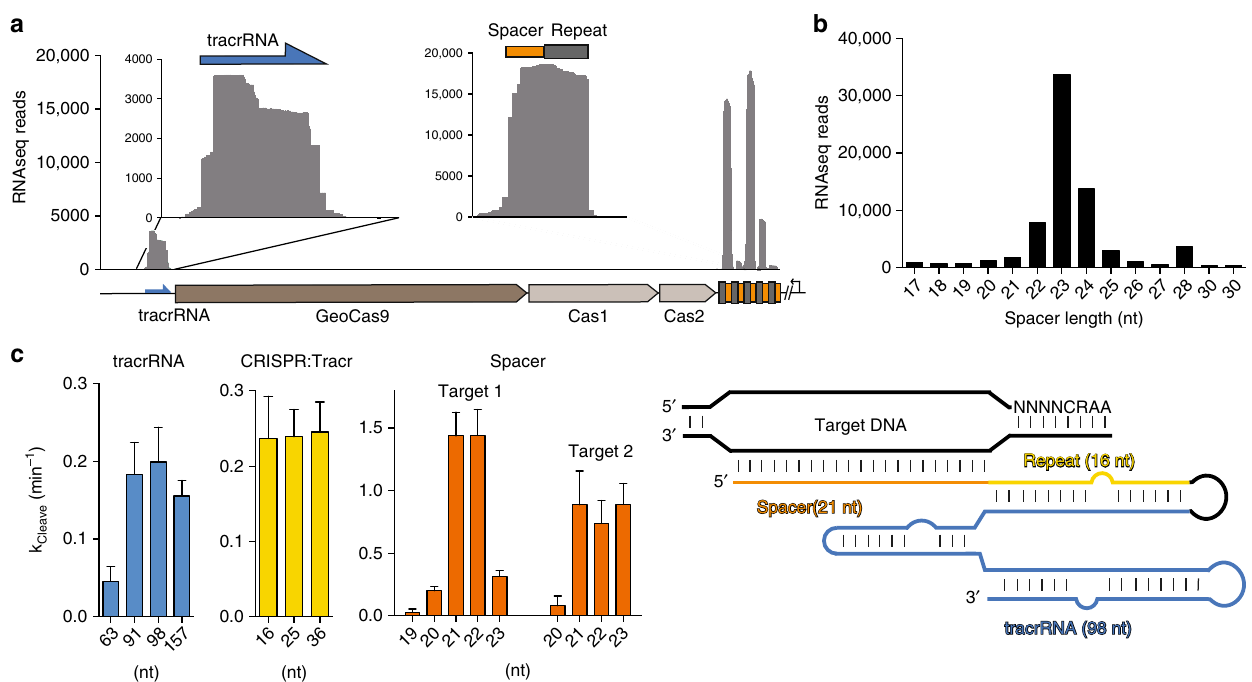
Fig. 3 Small RNA-seq and sgRNA engineering for GeoCas9. a Small RNA sequenced from G. stearothermophilus mapped to the CRISPR locus. Inset shows enlargement of the region corresponding to the tracrRNA and the most highly transcribed repeat and spacer sequence. b Distribution of the length of the spacer sequences extracted from the small RNA sequencing results. c Length optimization of the tracrRNA and crRNA for GeoCas9 and the optimal guide RNA design (right). The length of the tracrRNA, crRNA:tracrRNA duplex and spacer was optimized sequentially by transcribing variations of the sgRNA and testing their ability to guide GeoCas9-mediated cleavage of a radiolabeled substrate. For spacer length, two different targets were used (Target 1 and Target 2). The mean k cleave ± S.D. is shown and experiments were conducted in